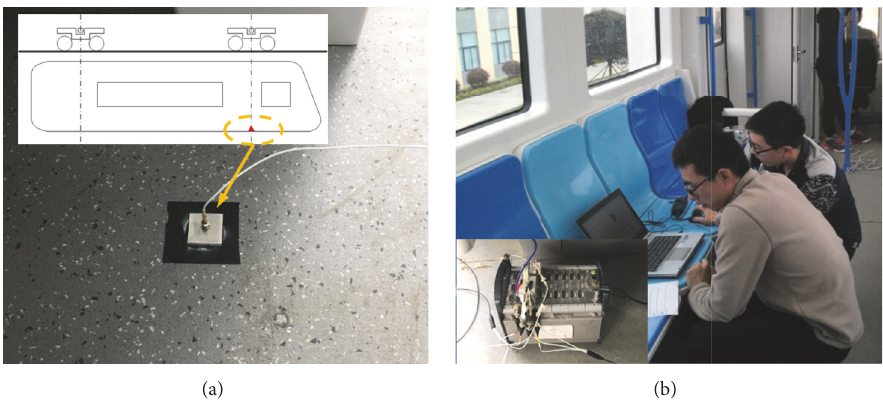
Figure 1: Acceleration measurement of the car body: (a) sensor position and (b) data acquisition.